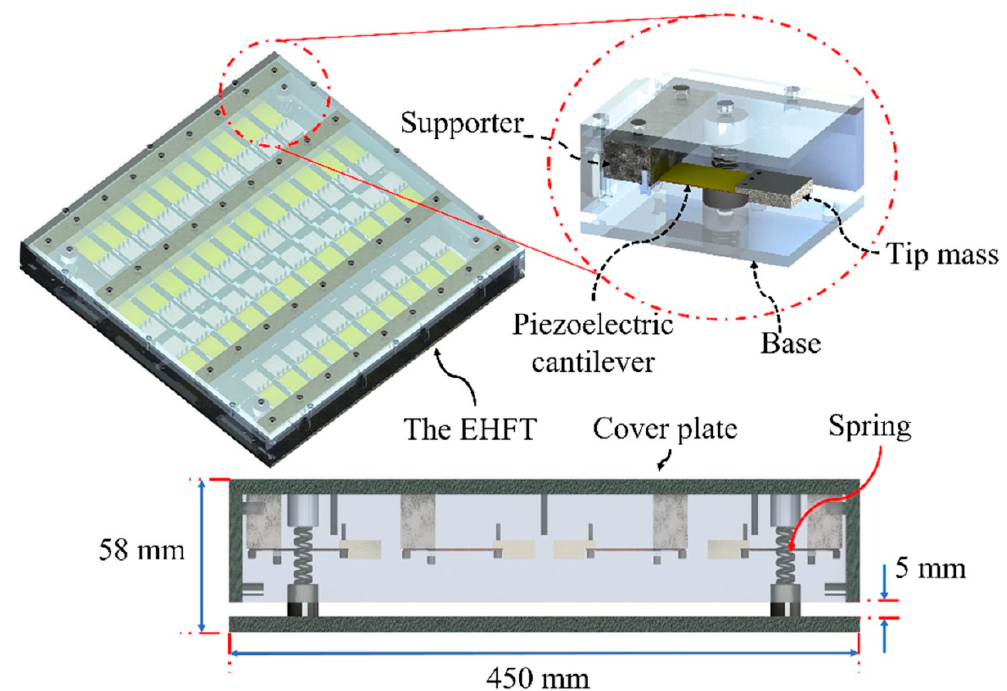
Figure 17. 3D and cross-section views of the piezoelectric EHFT proposed in [42].